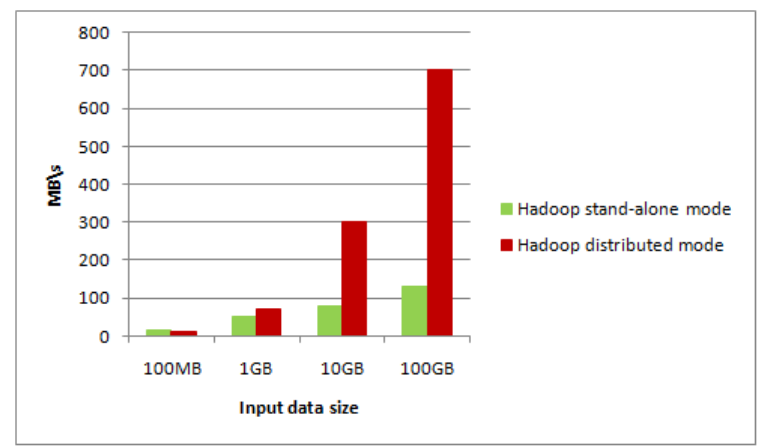
Figure 8. Throughput rate comparison between two modes.